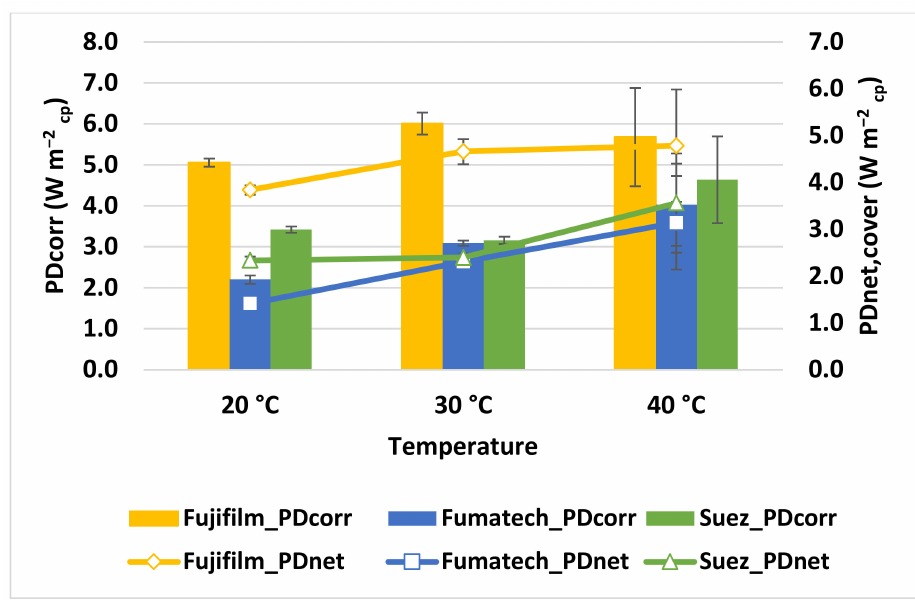
Figure 6. Influence of temperature on power density for the different IEMs under the experimental